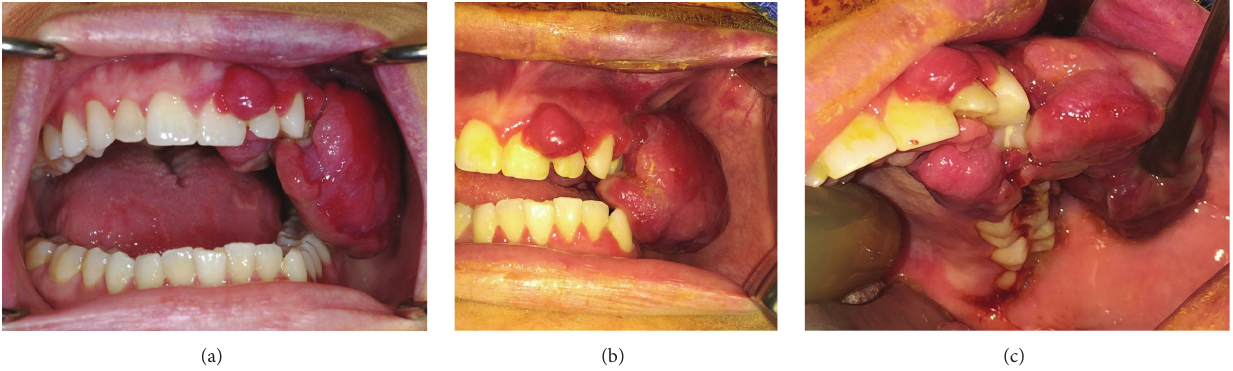
Figure 1: Intraoral frontal photographs at initial presentation with patient in maximum open (a) and closed (b) positions. A red-purple edematous growth is appreciated containing three sublesions: prominent left posterior maxillary buccal, left anterior maxillary buccal, and palatal extensions. The bulk and extent of the lesion prevent the patient from fully occluding. With the lesion retracted (c), the underlying dentition can be appreciated. The port-wine stain of the left upper lip and labial mucosa is evident. The patient is also noted to have geographic tongue as variable sized bald, flat red patches can been seen on the tongue dorsum.